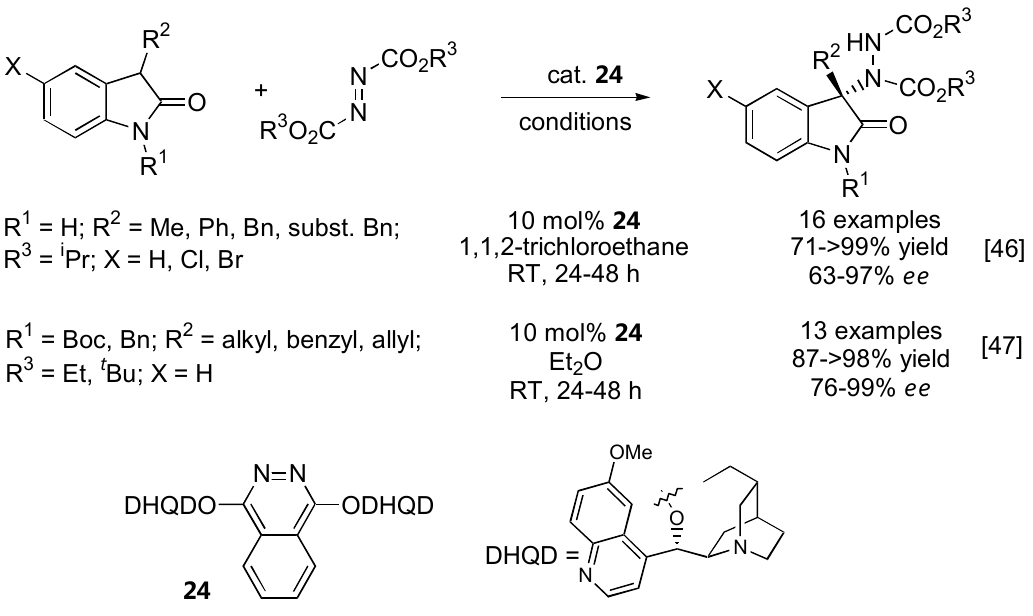
Figure 9. Direct  -amination of 3-substituted 2-oxindoles catalyzed by 24 [46,47].